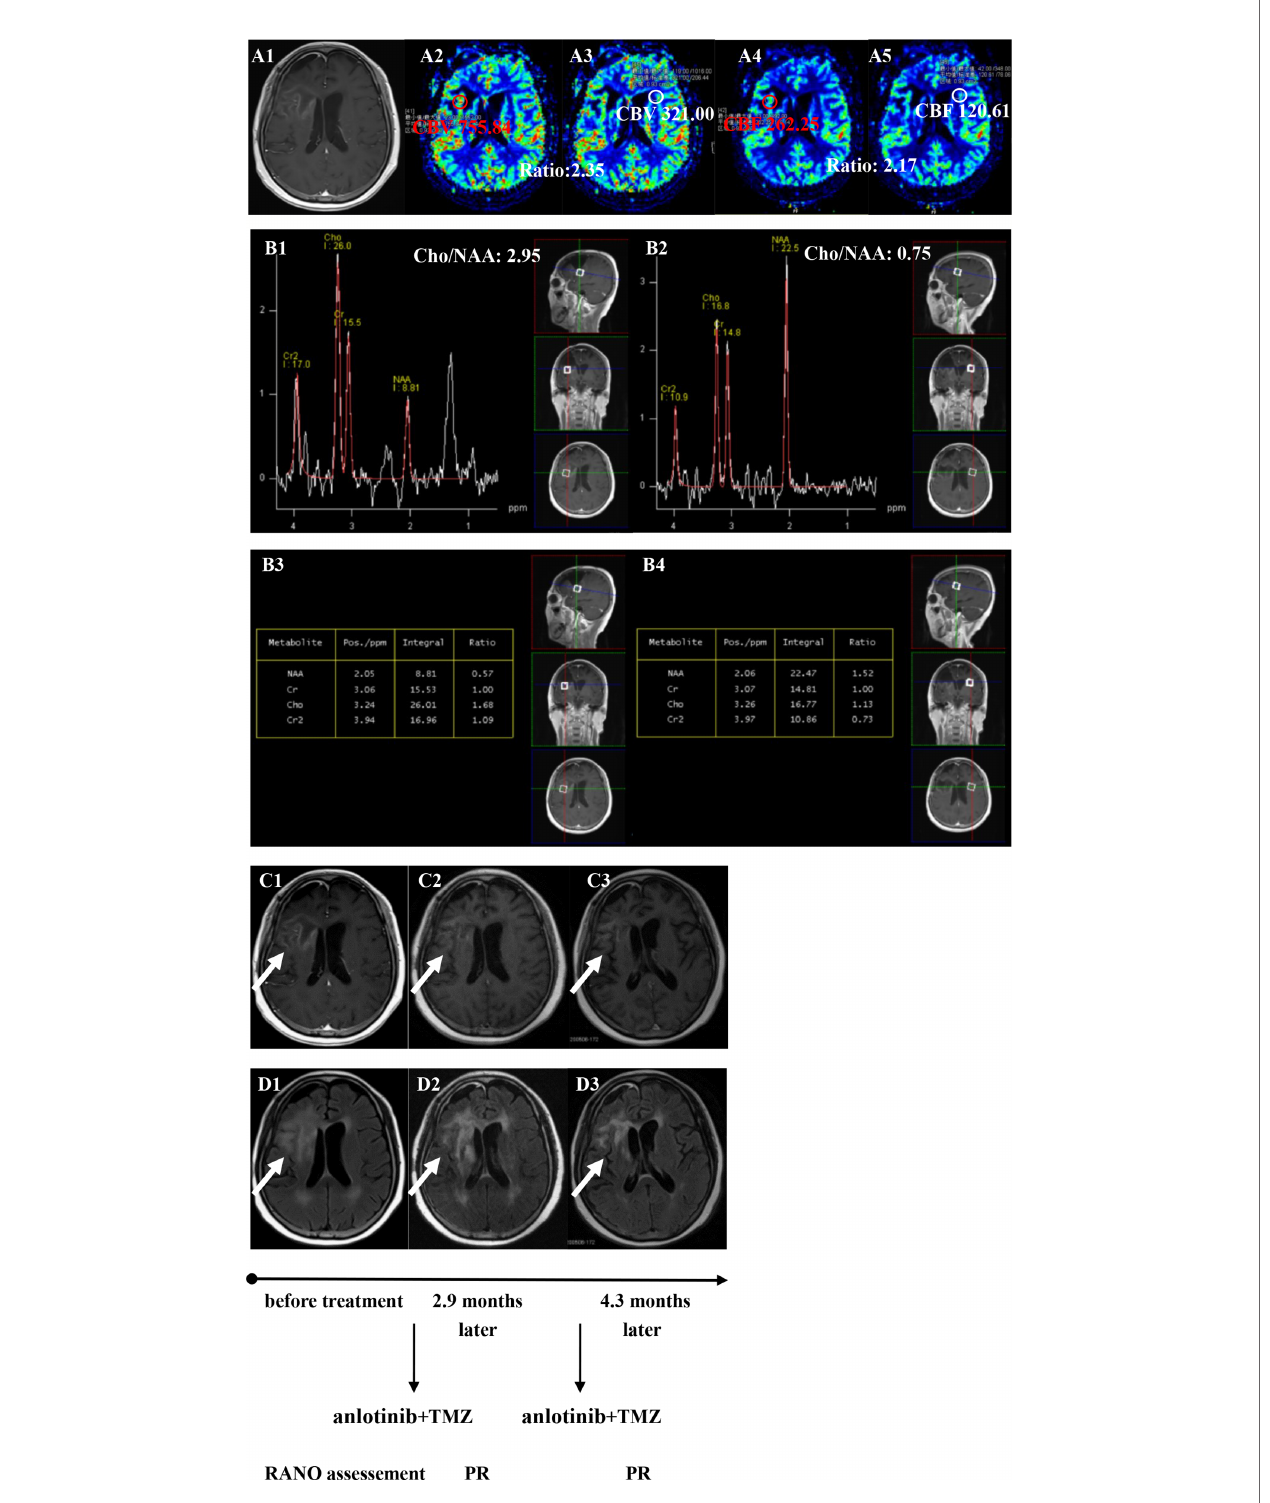
FIGURE 5 | Brain scan of patient number 3 (IDH1 − ; in situ recurrence. The interval time between the end of CCRT and the treatment of anlotinib combined with TMZ was 3.2 months). (A1 – A5) Perfusions maps at the time of recurrence; (B1 − B4) MRS at the time of recurrence; (C1 – C3) Contrast-enhanced MRI; (D1 – D3) MRI-Flair; MRI images followed-up every 1 to 3 months before and after treatment. The arrow refers to the area of recurrence. The patient achieved partial remission after treatment and had a progression-free survival time of 5.8 months.